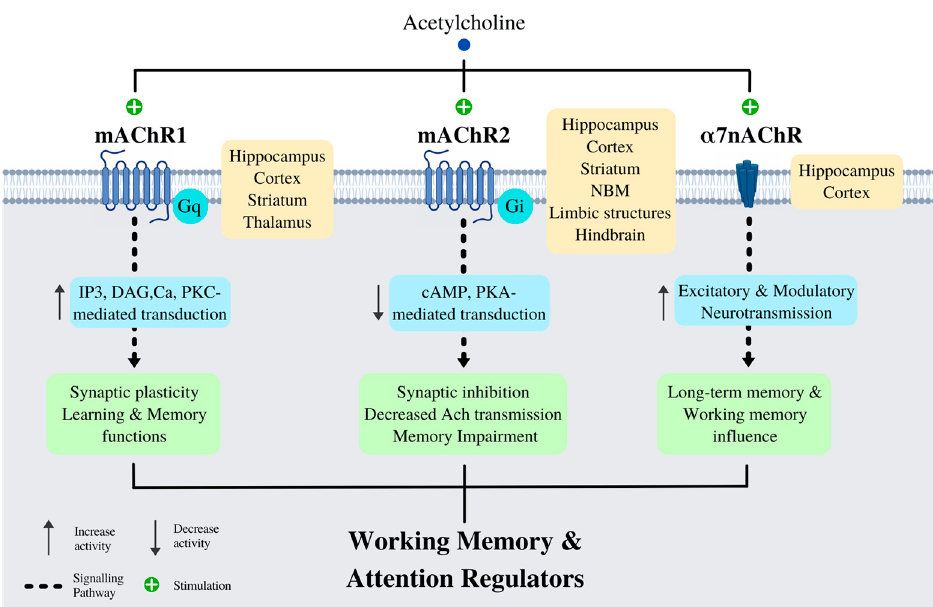
Figure 4. Acetylcholine receptors and their influence on Working Memory & Attention. The three main cholinergic receptors that influence working memory and attention are: The M1 muscarinic acetylcholine receptor (mAChR1), M2 muscarinic acetylcholine receptor (mAChR2), and the α 7 nicotinic acetylcholine receptor ( α 7 nAChR). These receptors are widely distributed across cortical and subcortical structures interplaying to regulate working memory and attention.